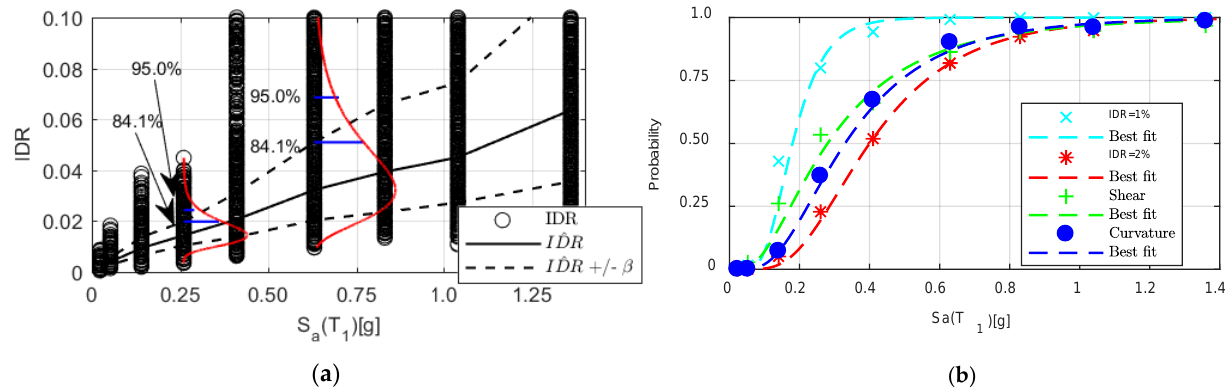
Figure 8. Multi-stripe analysis results for the 8-story case study building; ( a ) inter-story drift ratio demands obtained at each intensity level; ( b ) probability of limit state exceedance and associated fragility curve.